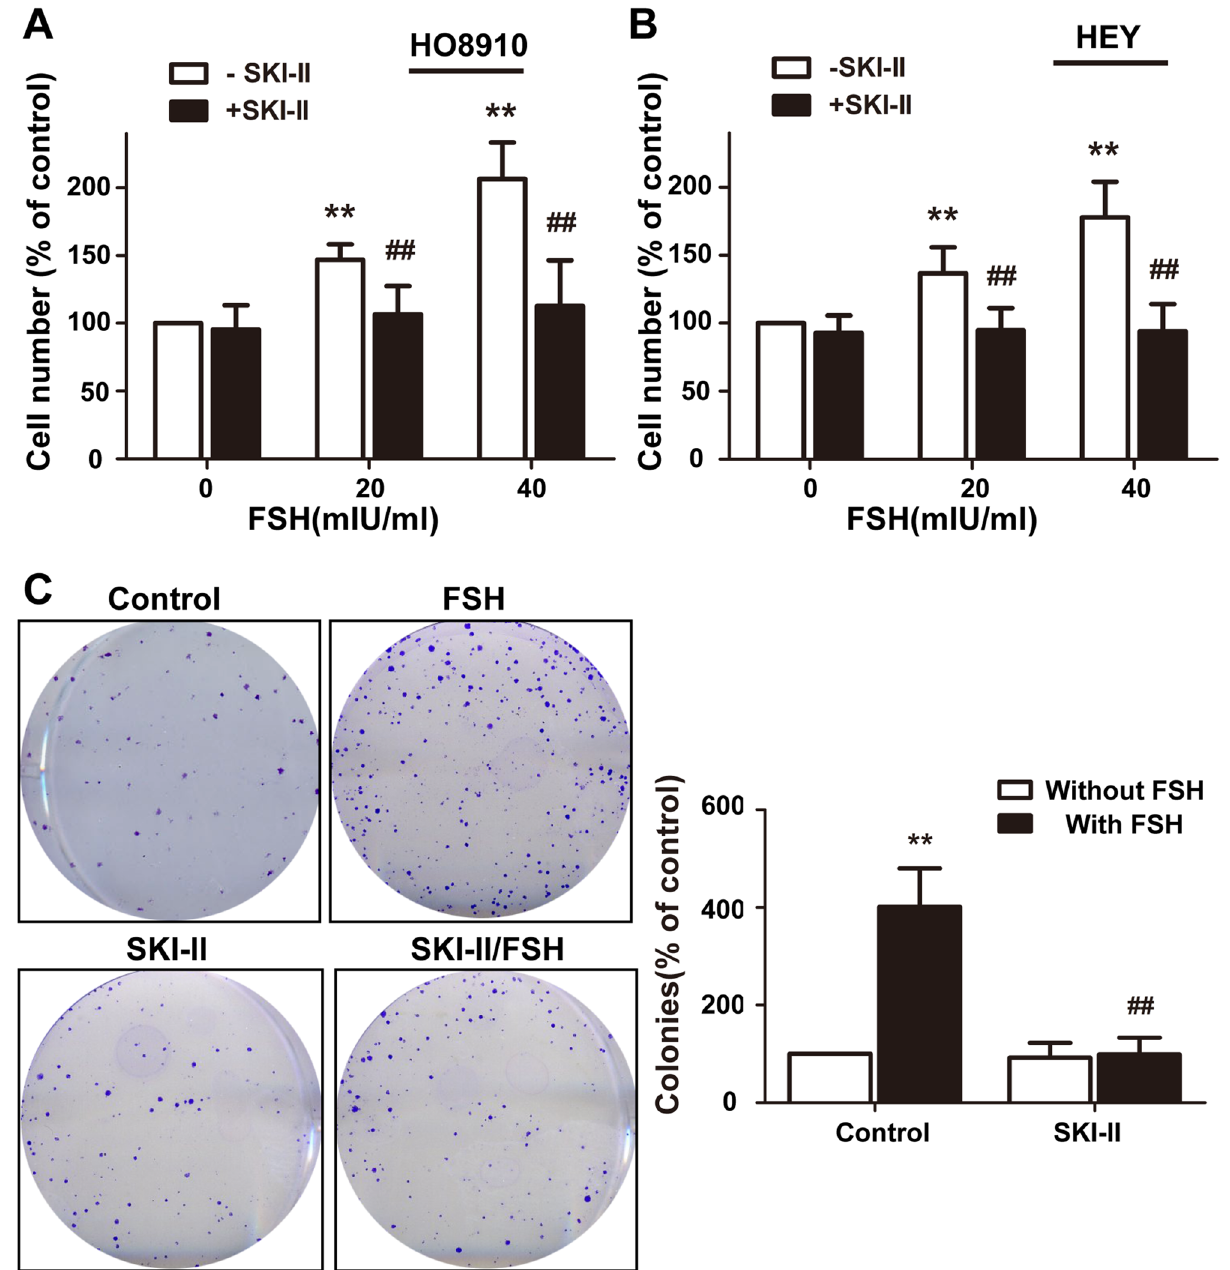
Figure 2. Inhibition of SphK abolished EOC cells proliferation stimulated by FSH. ( A ) HO8910 cells were serum-starved for 24 h and stimulated by FSH (40mIU/ml) with or without SKI-II (2.5 µM) for 72 h. Cell growth was measured using the CCK-8. ( B ) The same treatment was performed in cell line HEY. ( C ) HO8910 was plated in six-well plates reached 1,000 cells/well and serum-starved. Then, cells were cultured with FSH (40mIU/ml) with or without SKI-II (1 µM) in medium supplemented with 1% fetal bovine serum. Colonies were counted at the end of 2 weeks. Data are mean ± SD. * P < 0.05, vs. control; # P < 0.05, vs. FSH